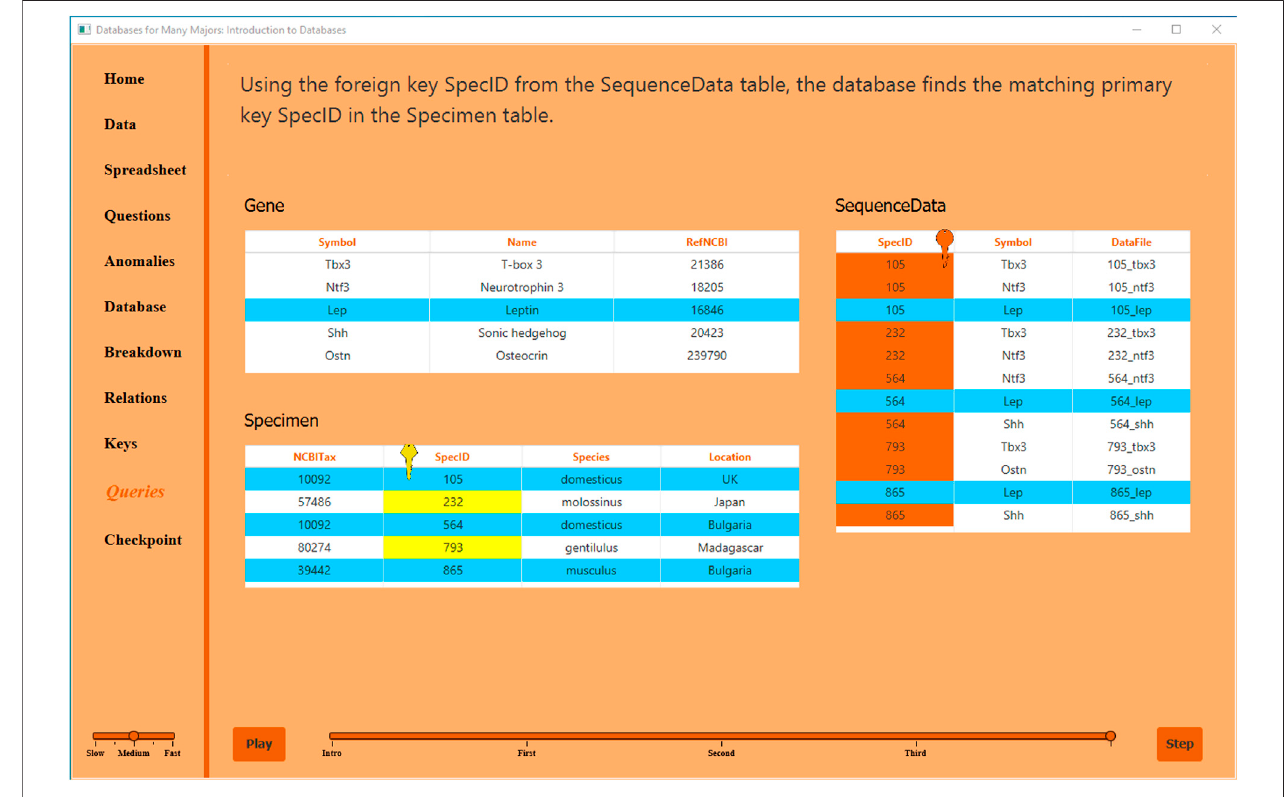
FIGURE 2 | IntroDB queries for customized computational molecular biology (CMB) visualization.